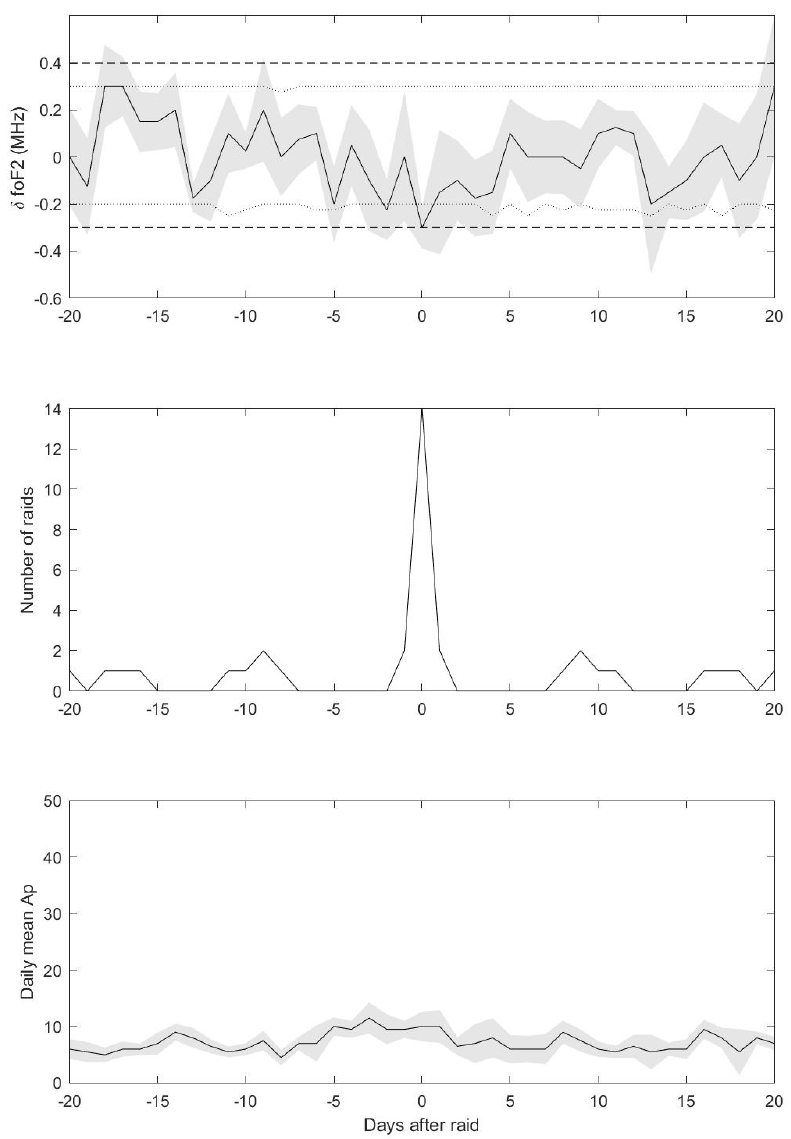
Figure 1. A superposed epoch analysis of the ionospheric response to major bombing raids over Europe. The black line in the top panel shows the median response in δ fo F2 ( fo F2 with a 30-day median subtracted) to 60 bombing raids used as a trigger event in the analysis. The grey shaded area represents the standard error in these median values, while the dashed and dotted lines represent the 95th and 99th percentiles of 10000 repeated analyses using random control days in which no bombing raids were identified. At time = 0 (within 24h of the trigger events) δ fo F2 is depleted (1.9 standard deviations from the mean). Arbitrary threshold values were used, corresponding to >